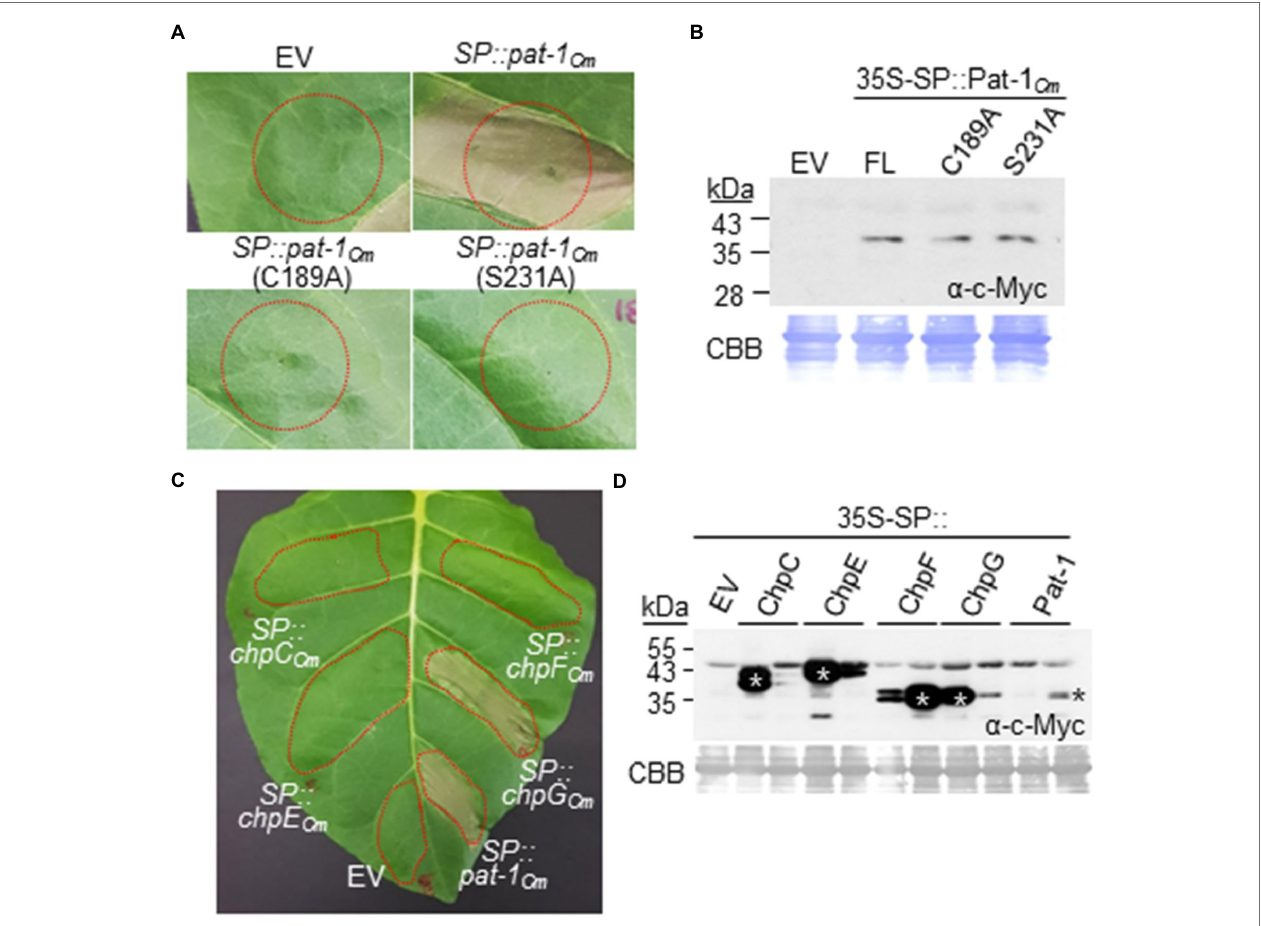
FIGURE 7 | Hypersensitive response-eliciting activity of Pat-1 Cm , its variants, and homologous Chp proteins by Agrobacterium -mediated transient expression in Nicotiana tabacum . Five-week-old N. tabacum leaves were infiltrated with Agrobacterium carrying each construct for constitutive expression of the indicated proteins with the SP of the tobacco PR1a protein. HR phenotypes in N. tabacum by expression of Pat-1 Cm and its variants (A) and homologous Chp proteins (C) were shown. Representative leaf was photographed 36 h after infiltration (hai). Red dotted lines indicate infiltrated regions. Empty vector (EV) was used as a negative control. (B,D) Western blotting of transiently expressed proteins tagged with c-Myc in their C-termini using c-Myc antibody. Infiltrated leaves were sampled at the time point before HR was fully progressed, and total proteins were extracted. * in (D) indicates the right bands for each protein. CBB, Coomassie Brilliant